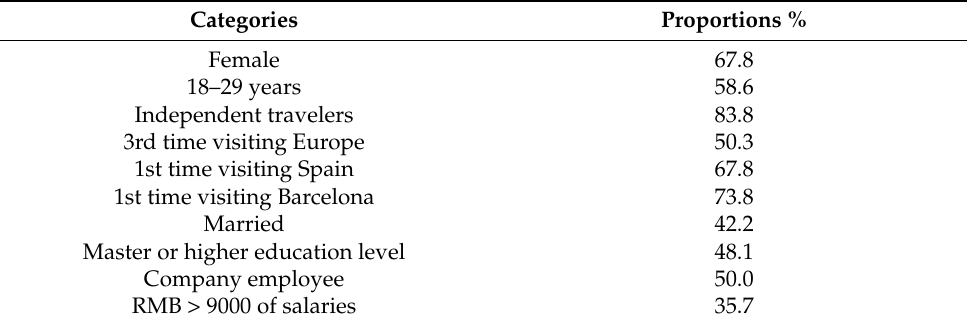
Table 2. Most frequency characteristics of the